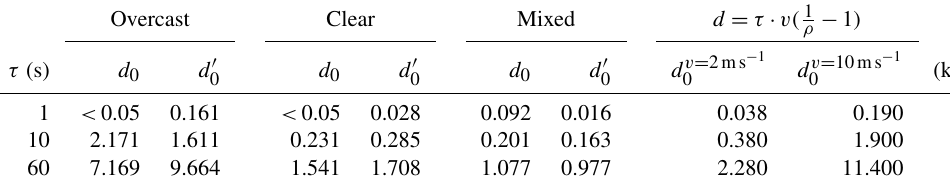
∗ (cid:48) = ˆ d · τ (for which ρ (cid:49)k = 0 . 05) estimated τ 0 ij 0